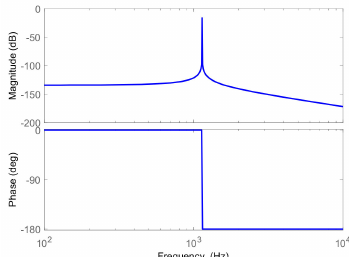
Figure 3. The amplitude frequency and phase frequency characteristic of the cylindrical resonator.